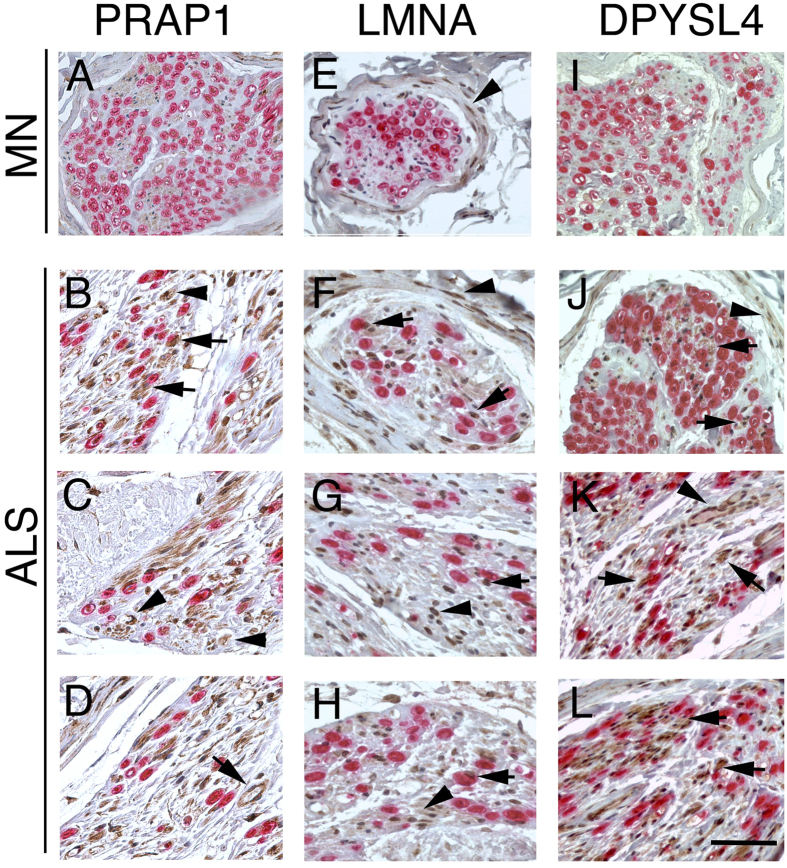
Immunohistochemistry localization of PRAP1, LMNA and DPYSL4 in MN and ALS motor nerves.Double staining for MBP (red), to mark myelinated nerve fibers, and PRAP1 (A–D), LMNA (E–H) and DPYSL4 (I–L) (brown) shows increase expression in ALS motor nerves. PRAP1 immunoreactivity was present in the endoneurium in numeorus cells (arrowheads, B,C) including cytoplasm of Schwann cells (arrows, B; MBP immunoreactivity identified the myelin sheath) and endothelial cells (arrow, D). LMNA shows immunoreactivity in the perineurium in both MN and ALS nerves (arrowhead, E,F); in ALS motor nerves, immunoreactivity was present in nuclei and cytoplasm of all endoneurial cells (arrowhead, G,H) and Schwann cells (arrows, F–H). In ALS motor nerves, DPYSL4 was expressed in perineurium (arrowhead, J) and in the cytoplams and nuclei of many cells (arrows in J–L) including endothelial cells (arrowhead, K) and Schwann cells (arrows J,K). Bar: (A,E,I) 50 μm; (F–H,J–L) 50 μm.